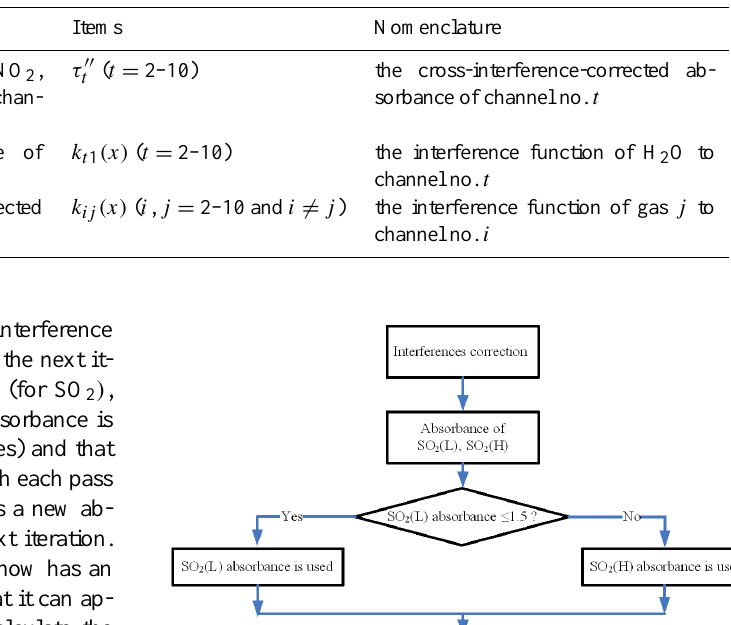
Table 3. The nomenclature in Fig. 3.